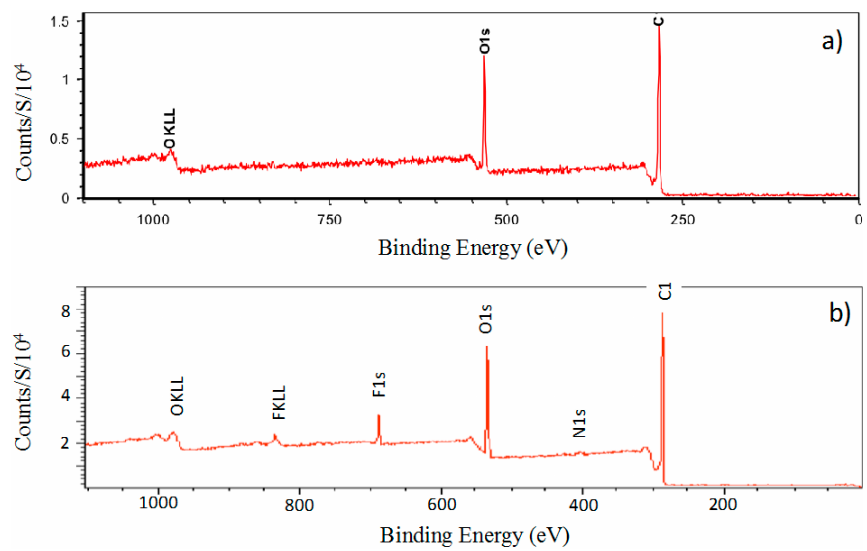
Figure 2. X-Ray Photoelectron Spectroscopy (XPS) analysis of ( a ) SU-8 film surface and ( b ) composite surface with 4 wt % ionic liquid